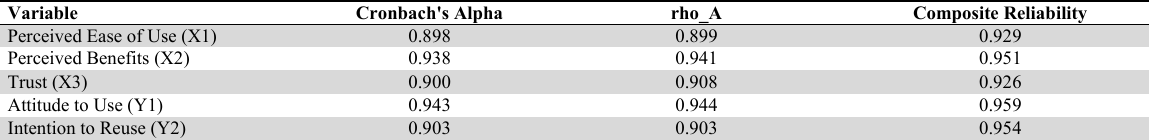
Composite reliability and Cronbach’s Alpha Coefficient Data